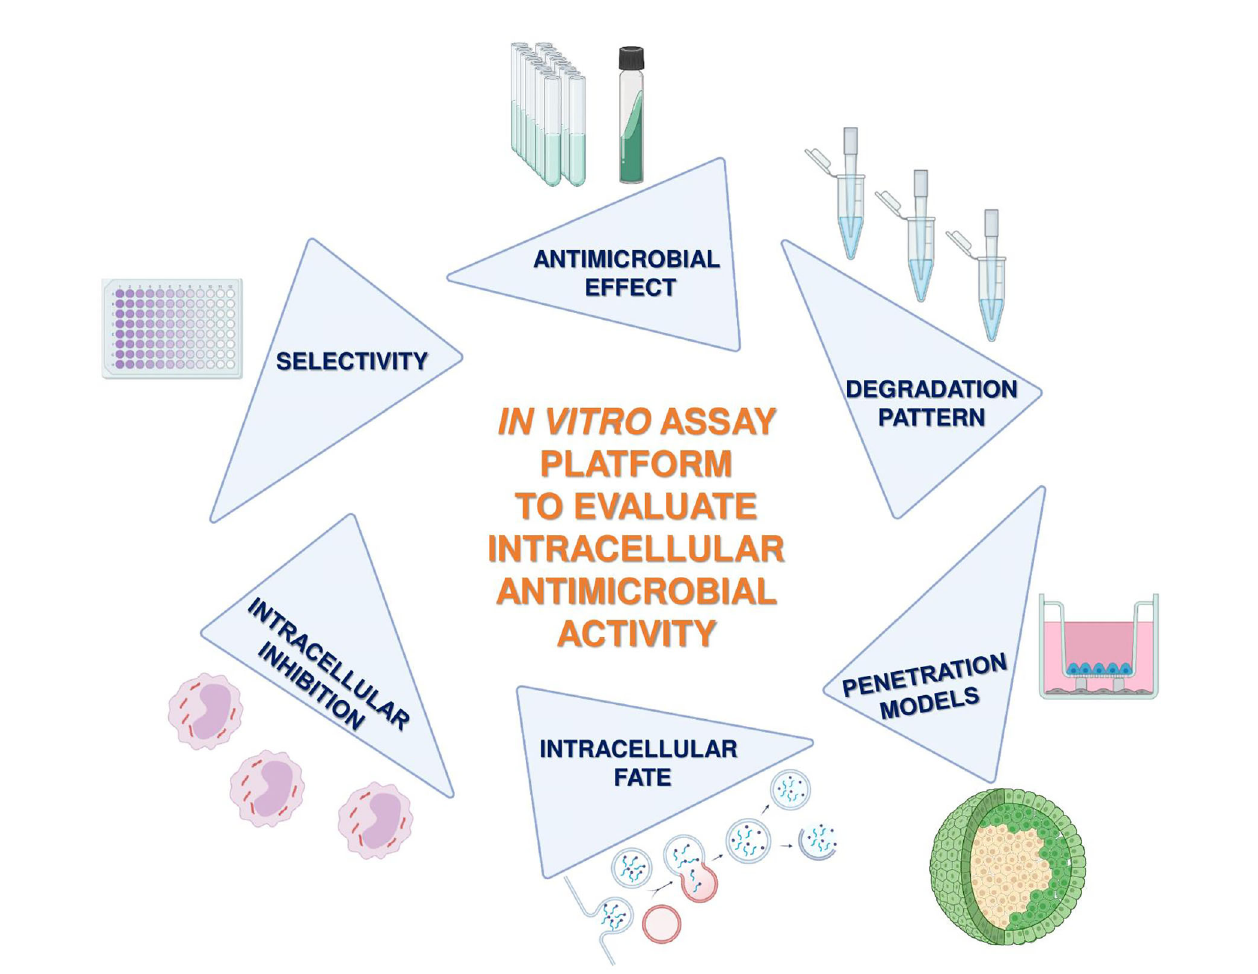
FIGURE 1 | Schematic fl ow chart of the proposed assay platform to de fi ne optimal candidates against intracellular pathogens. The main steps of the experimental setup: (i) activity on extracellular bacteria, (ii) determination of selectivity on potential human host cells, (iii) intracellular killing ef fi cacy, (iv) internalization and intracellular localization, (v) penetration ability on tissue-mimicking 3D spheroids and on Transwell-based noncontact coculture interfaces, and (vi) degradation